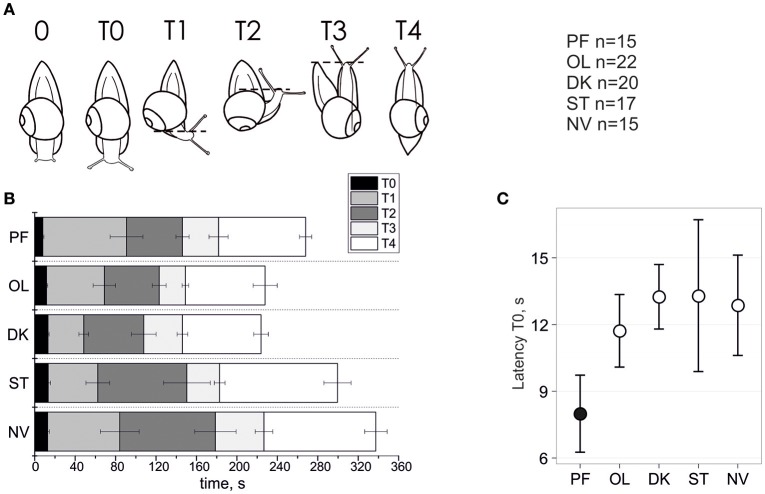
Temporal parameters of snail gravitaxis reaction. (A) Designation of 6 gravitaxis phases based on stereotypic behavior of snails. (B) Start, stop, and duration of the 6 gravitaxis phases (in sec) in the 5 separate snail groups (bars, ± Standard Error of the Mean). (C) Latency of T0 phase (tentacles elongation) in all snail groups, mean and 95% CI.